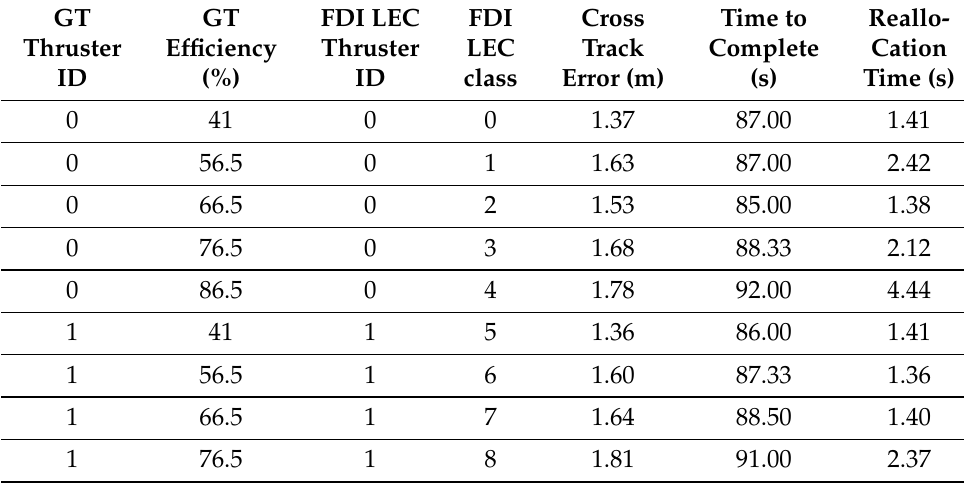
Table 5. Waypoint scenario with